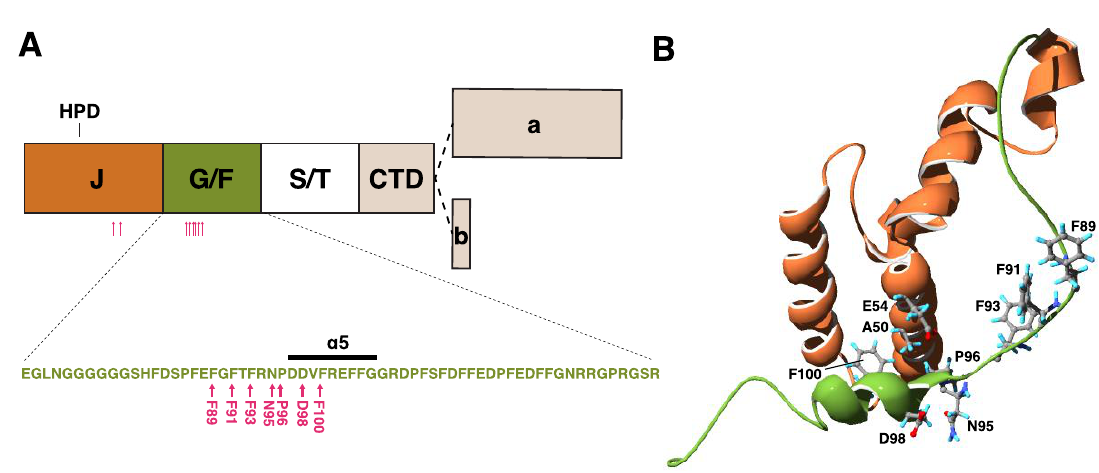
Figure 2. Structure of DNAJB6 and mutations. ( A ) A schematic view of the DNAJB6 protein, with the various domains, and the alternatively spliced C-terminal parts of the “a” and “b” isoforms indicated. The inset shows the sequence of the glycine / phenylalanine-rich (G / F) domain, with the α 5 helix and myopathy-causing mutations (pink arrows). ( B ) Protein structure of the J (orange) and G / F (green) domains, with residues harboring disease mutations shown. Structure from Protein Data Bank ID 6U3R [28].